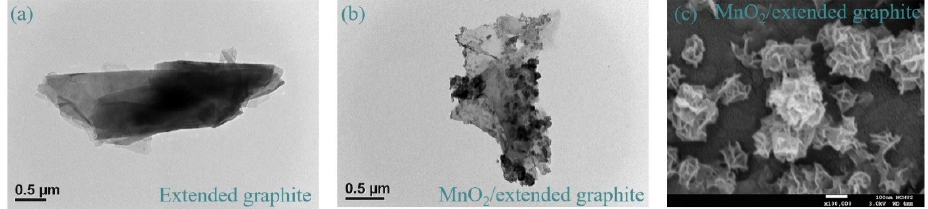
Figure 1. FETEM of ( a ) extended graphite and ( b ) MnO 2 /extended graphite. ( c ) FESEM of MnO 2 /extended graphite.